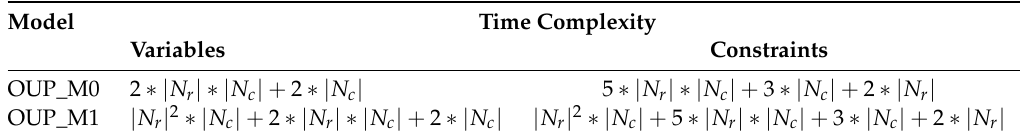
Table 7. OUP Complexity